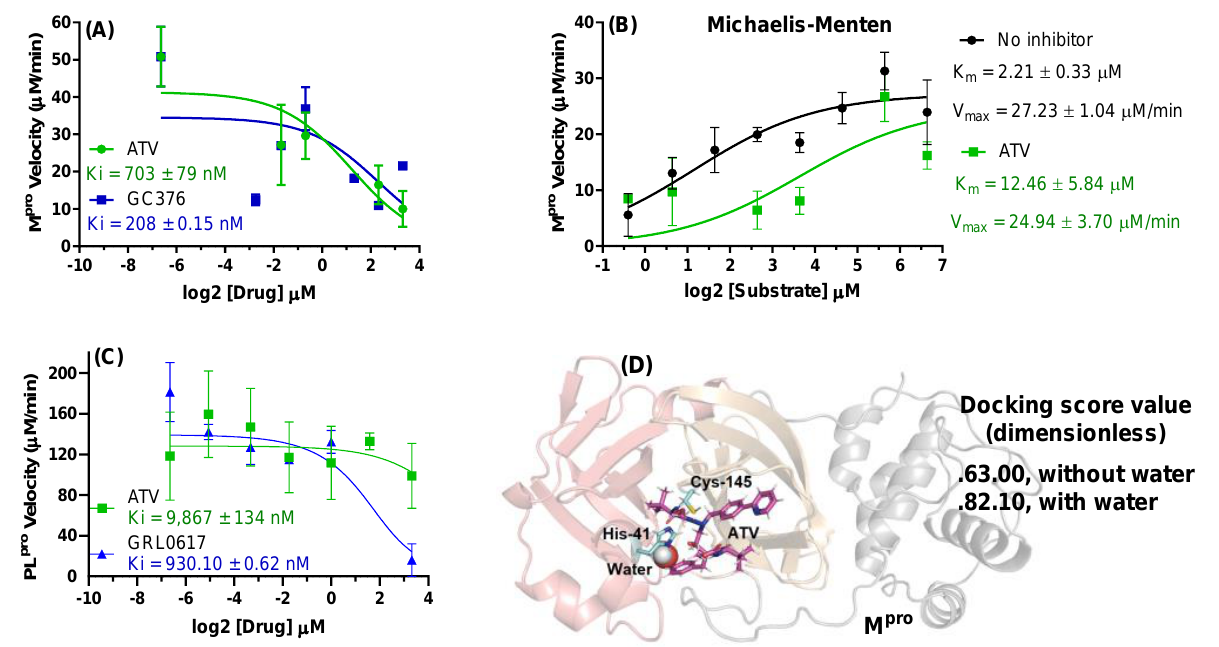
Figure 2. ( A ) The ATV and GC376 (positive control) activity on 88.8 nM M pro velocity at 0–10 µ M of inhibitor. ( B ) Michaelis–Menten plot for 88.8 nM M pro incubated with substrate concentrations from 0 to 100 µ M in the presence and absence of 2.5 µ M of ATV. ( C ) The ATV and GRL0617 (positive control) activity on 100 nM PL pro velocity at 0–10 µ M of inhibitor. ( D ) The 3D representation of the best docking pose for ATV into M pro catalytic site in the presence of the catalytic water (H 2 O cat ). For better interpretation the M pro structure was represented only in the monomeric form with the domains I, II and III in light red, orange, and gray, respectively. Table 1. In vitro pharmacological parameters for ATV and RDV against SARS-CoV-2 variants in Calu-3 cells. ATV RDV Strain MOI EC 50 (μM) CC 50 (μM)